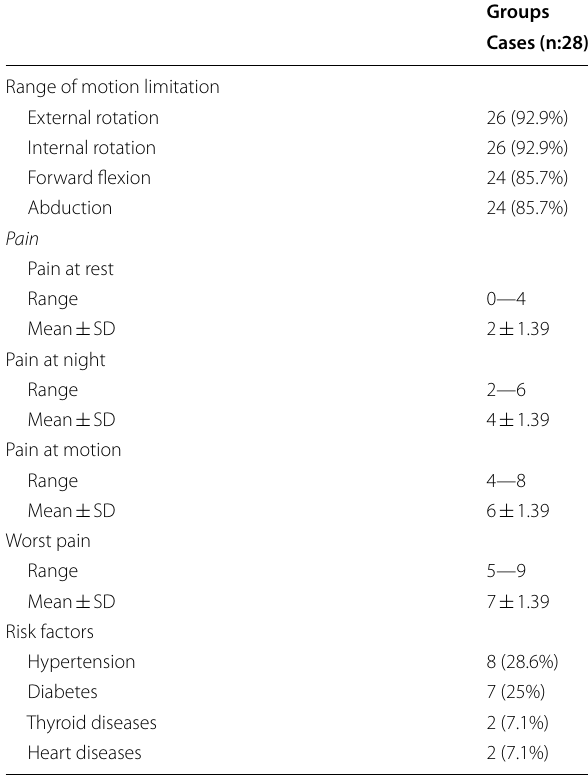
Table 3 Clinical signs and risk factors for adhesive capsulitis